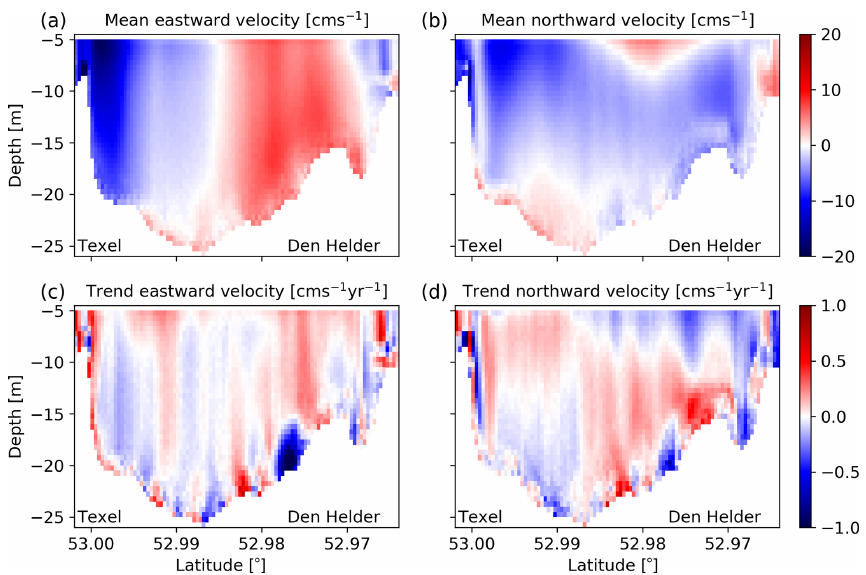
Figure 7. Long-term mean horizontal velocities in the east (a) and north (b) direction and their respective trends (c, d) . In (a) red indicates an inflow (flood). Levels near the surface subject to vertical tidal changes were excluded. The direction of view is in the eastward or flood